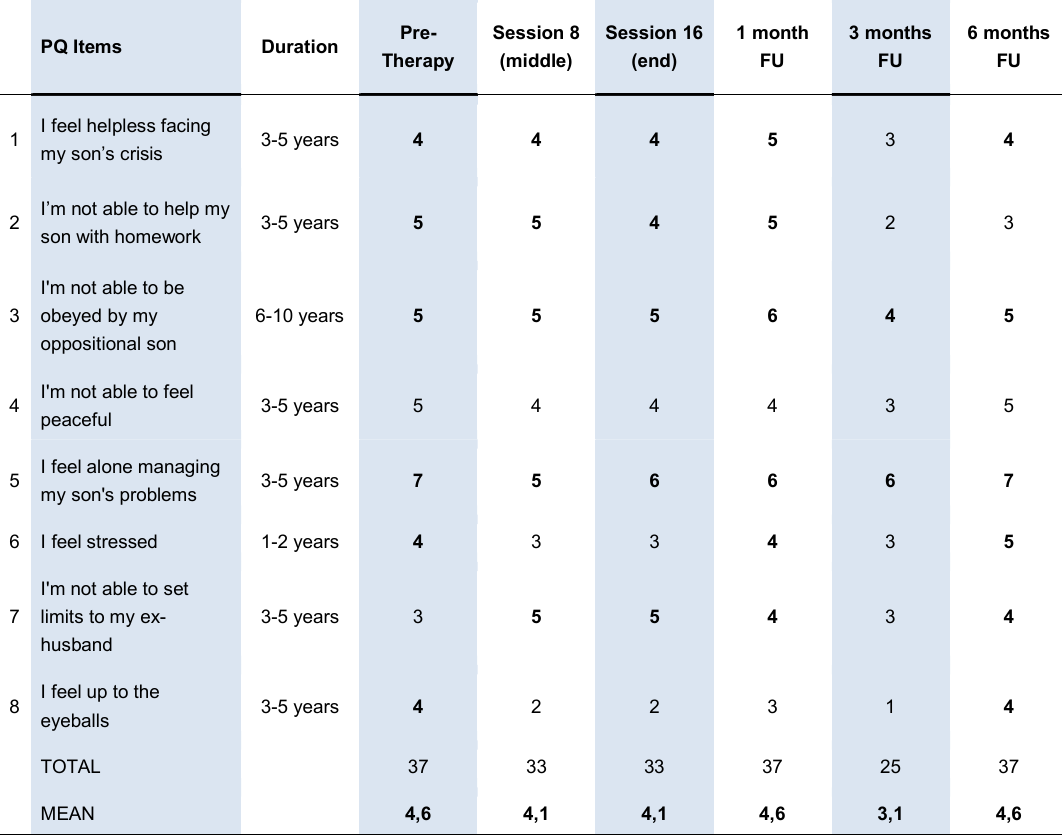
Table 2: Penelope’s Personal Questionnaire